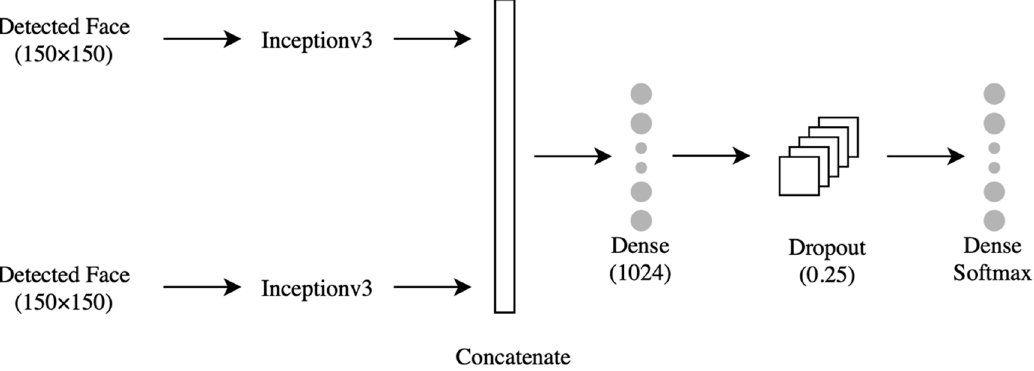
Figure 6. The concurrent shallow CNN model using InceptionV3 with frozen layers.